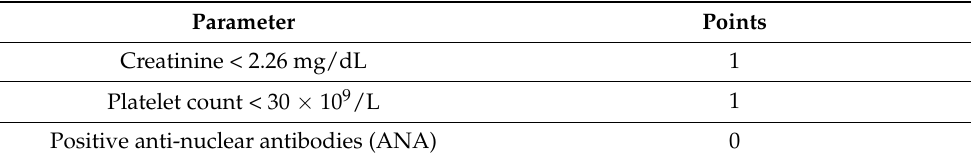
Table 4. French TMA score calculated 6 h after admission.